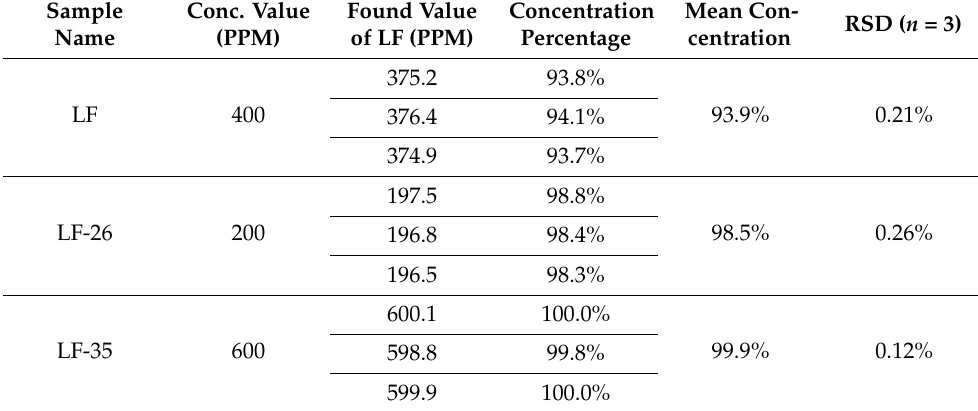
Table 4. Levofloxacin levels after four weeks of testing for stability towards UV lighting.